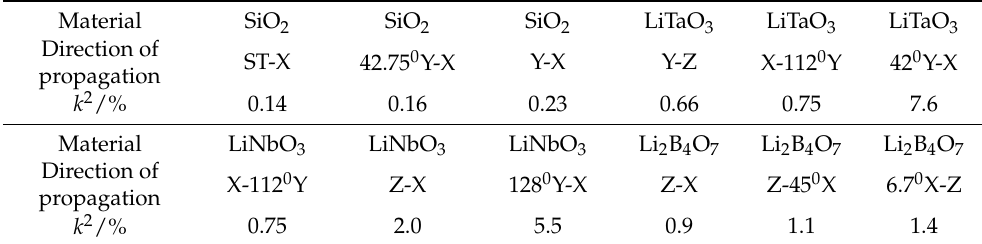
Table 1. Piezoelectric substrate materials and their k 2 .